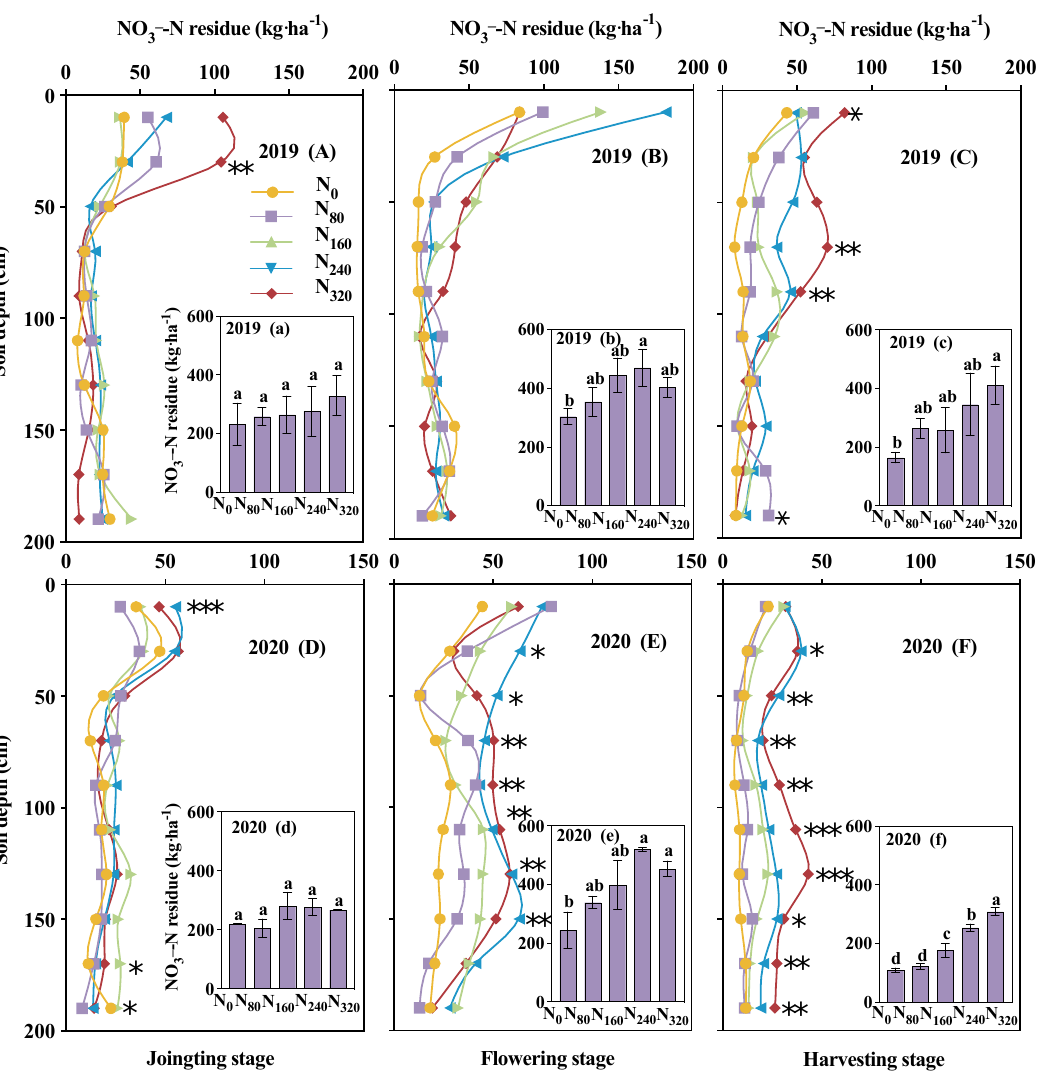
Figure 6. Mean values of NO 3 − − N residue in different soil layer at the jointing ( A , D ), flowering ( B , E ), and harvesting stages ( C , F ) of forage sorghum and the sum of NO 3 − − N residue in the 0 − 200 cm soil layer under different N application rates in 2019 and 2020 ( A − F ). Each point and each bar are the average of six repetitions. Different lowercase letters indicate significant differences at p < 0.05 among the different N treatments. *, **, and *** indicate significant differences at p < 0.05, p < 0.01, p < 0.001 at the same soil layer among the different N treatments.